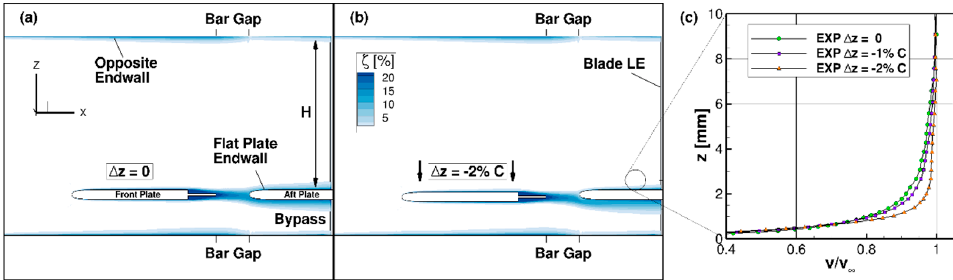
Figure 18. Effect of the flat plate misalignment on the inlet endwall boundary layer of the T106A cascade.